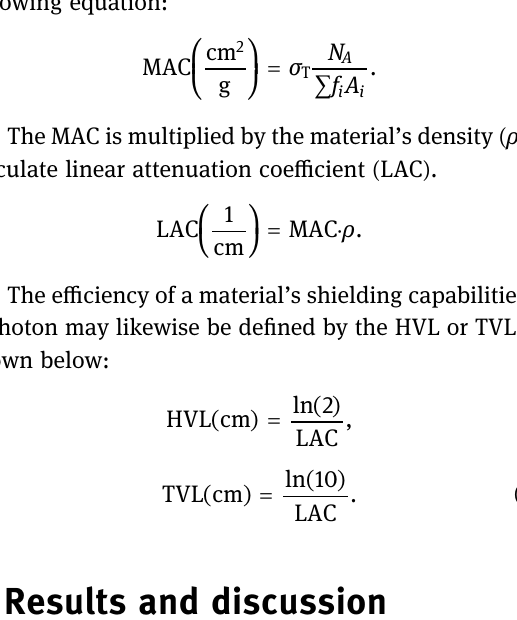
increase in ρ from 4.334 to 5.742 g/cm 3 ascribed to the substitution of B atoms by Bi atoms. The molar volume ) gradually rose from 37.197 to 38.429 cm 3 /mol when ( V m Bi O increased from 10 to 25 mol%. The openness of the 2 3